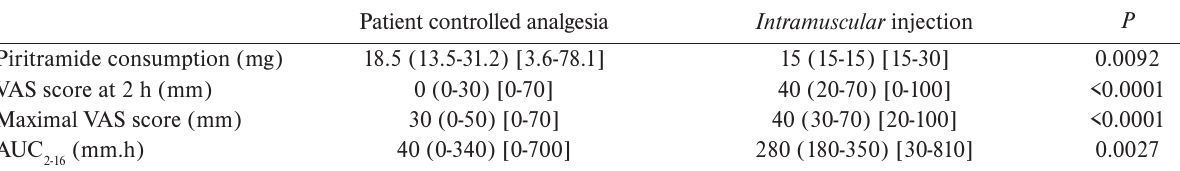
Table 2. Piritramide consumption and analgesic efficacy parameters.